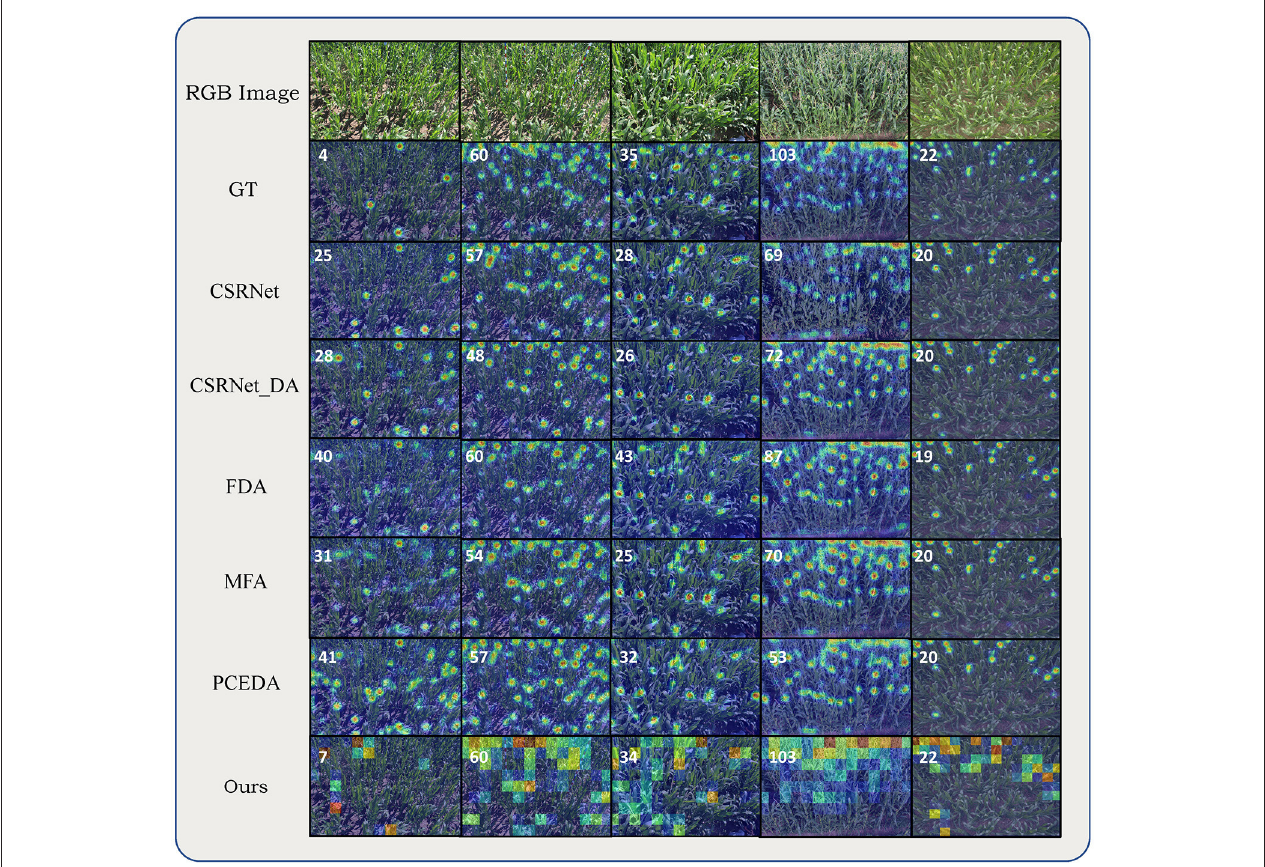
FIGURE 6 | Qualitative comparisons on MTC dataset. From top to bottom alternating: RGB image, ground truth density map, density maps (count maps) estimated by CSRNet, CSRNet_DA, FDA, MFA, PCEDA, and our method. Numbers in the upper left corner of estimated density maps (count maps) represent the ground-truth or predicted counting value (rounded).